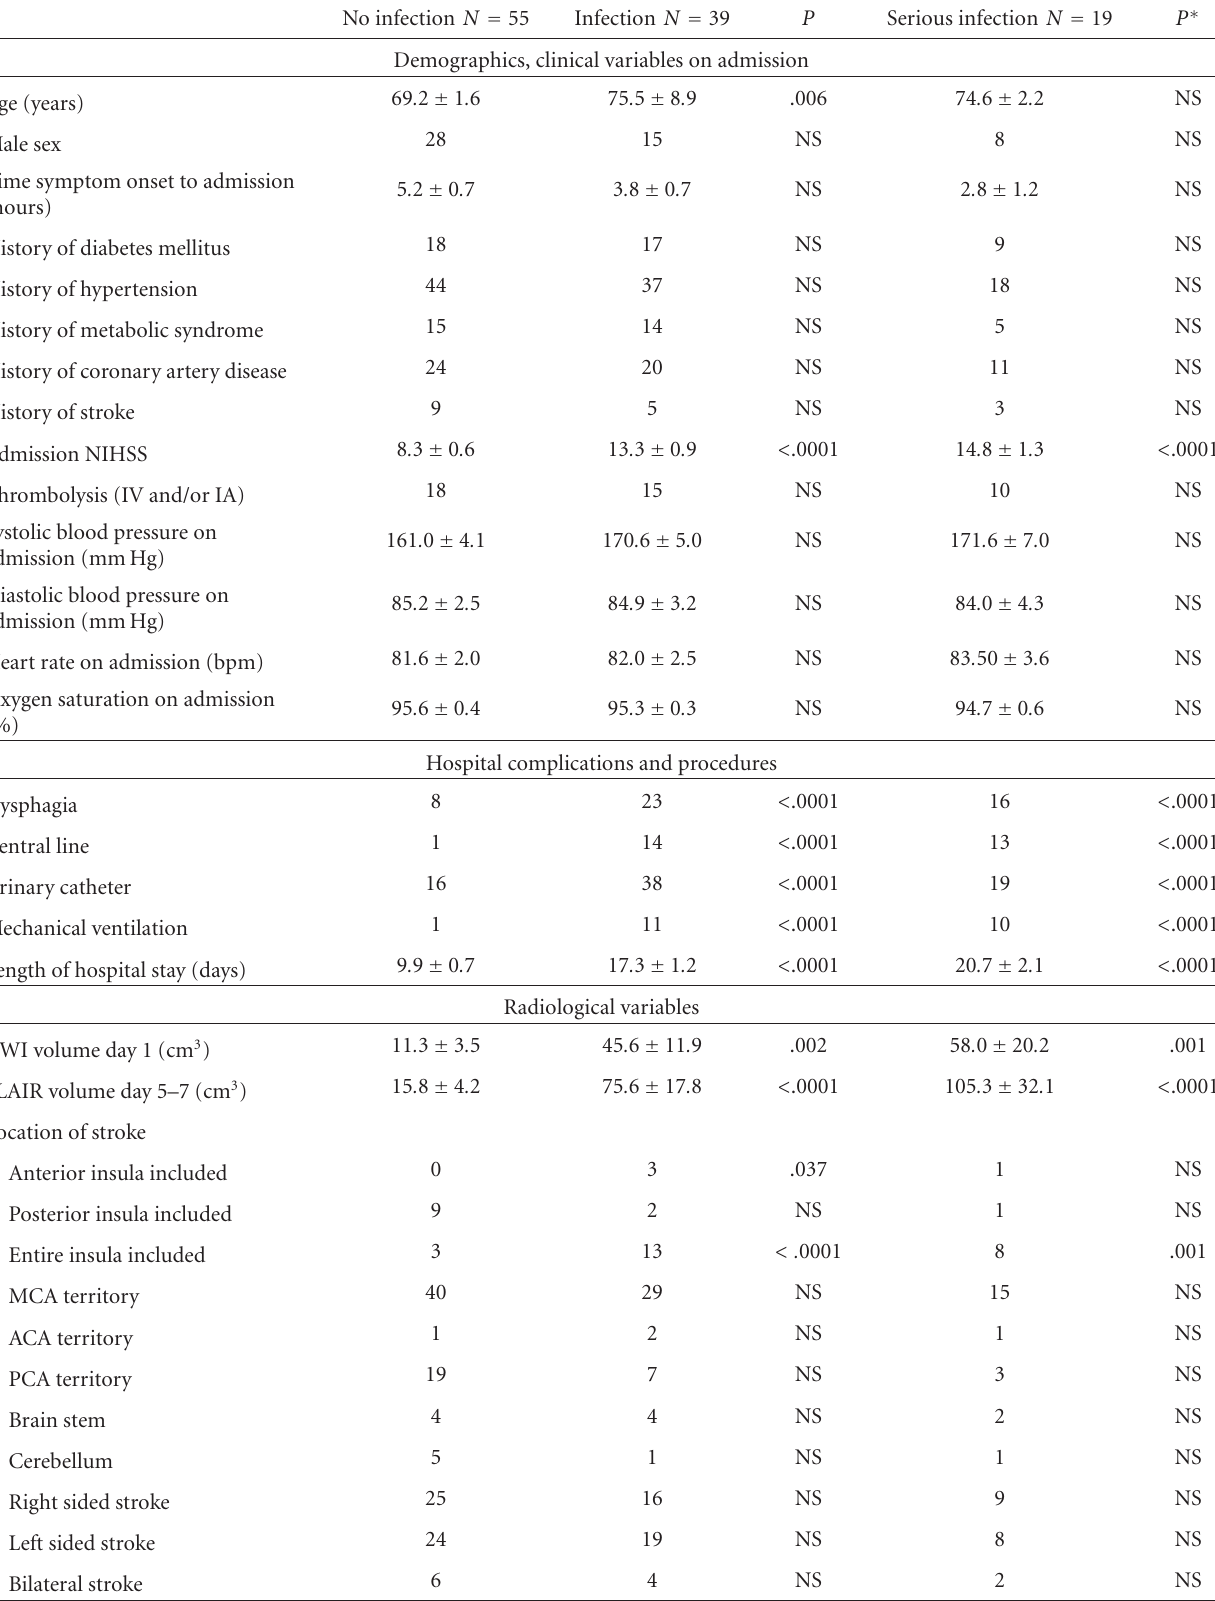
Table 1: Univariate associations of demographic, baseline, vital signs, hospital complications, and procedures with the development of an infection and serious infection during the hospital